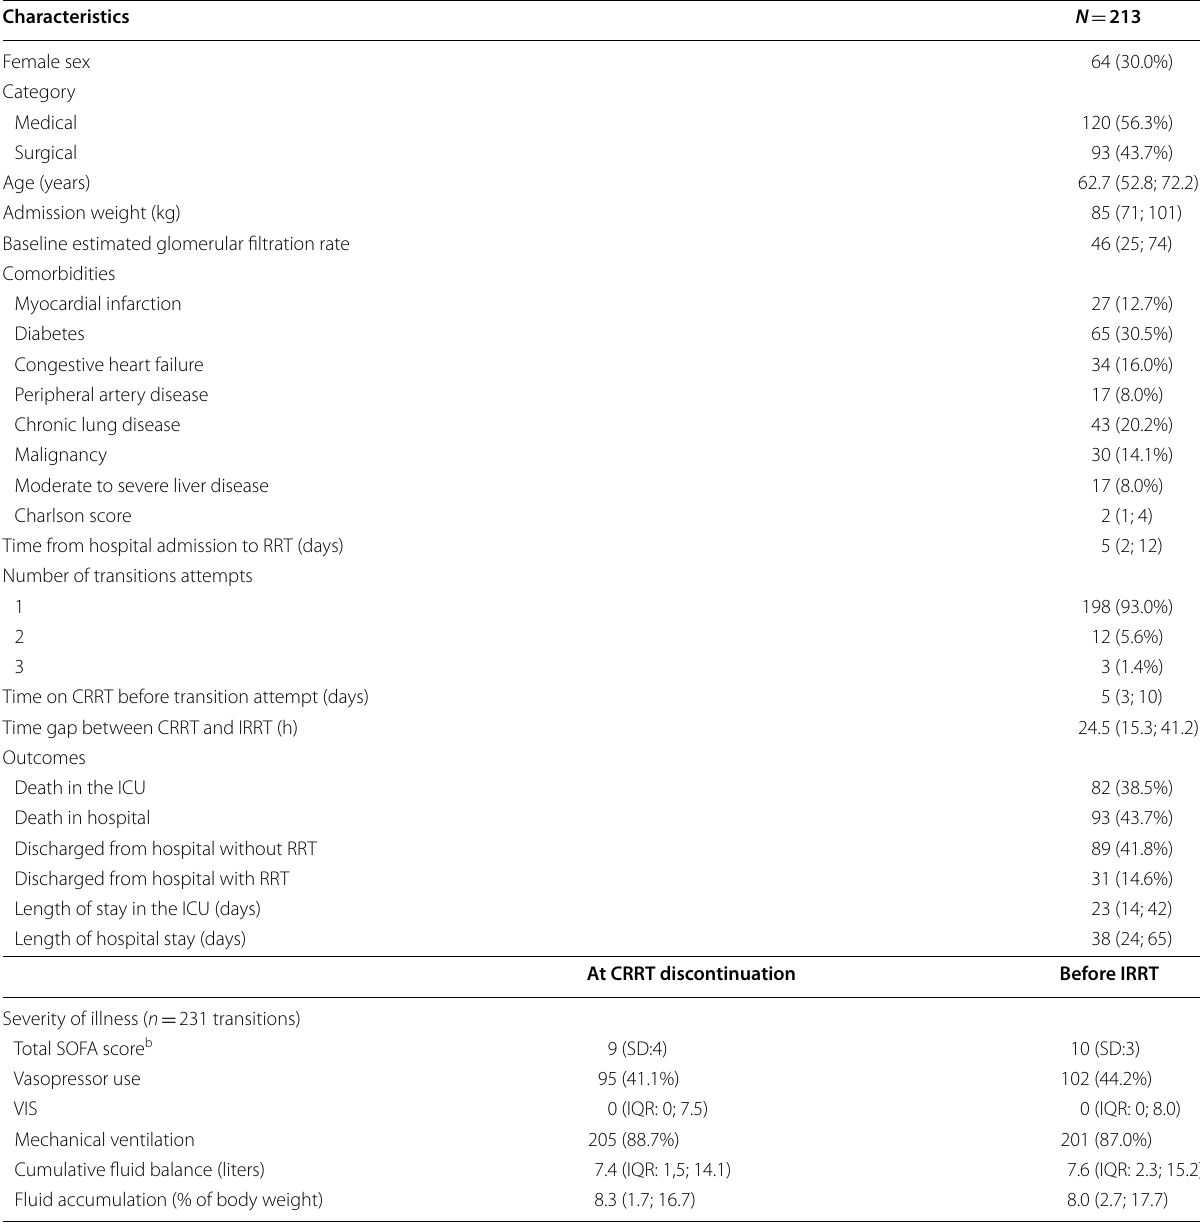
Table 2 Patient